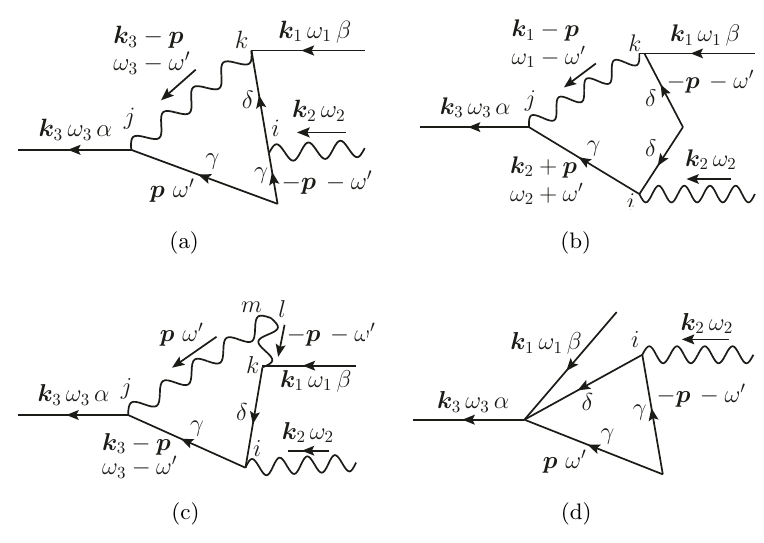
Figure 8 . Diagrams for V